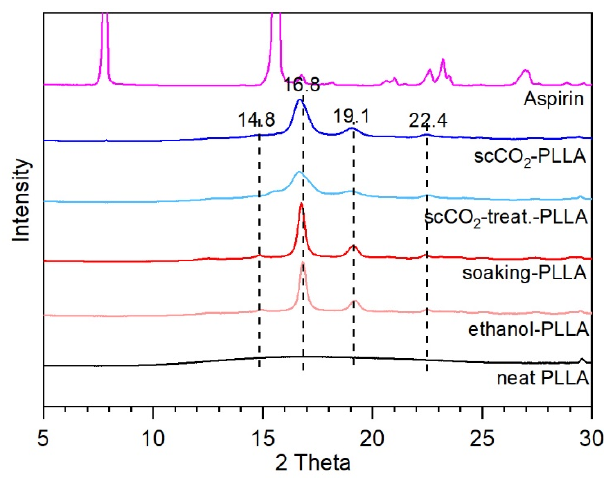
Figure 6. XRD patterns of neat PLLA, ethanol-PLLA, scCO 2 -treated-PLLA, soaking-PLLA, and scCO 2 -PLLA.